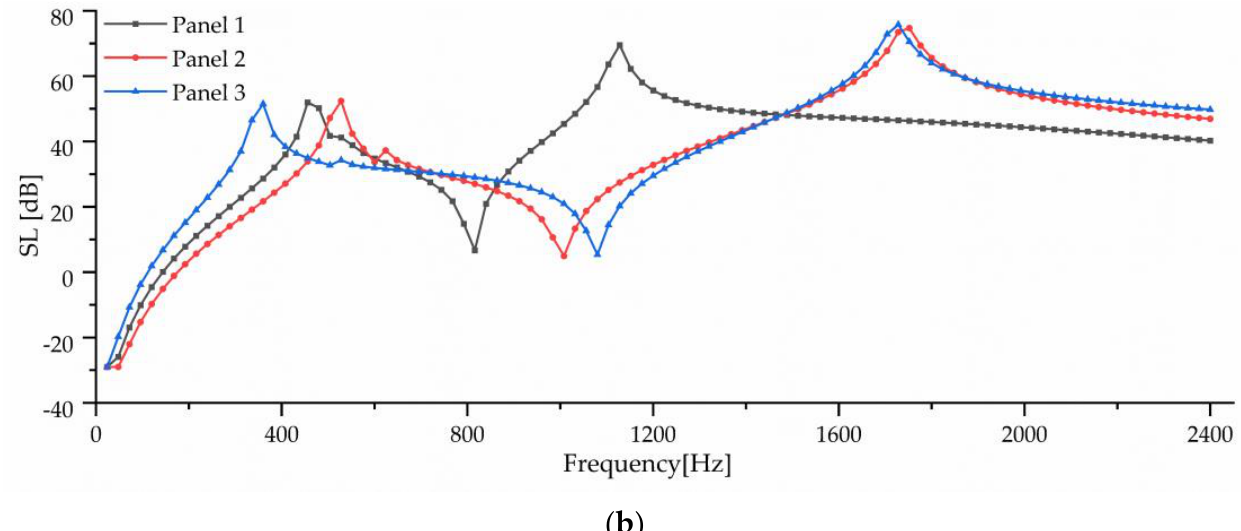
Figure 10. Comparison of vibration velocity and sound source level for three basic configurations. ( a ) Surface vibration velocity. ( b ) SL.